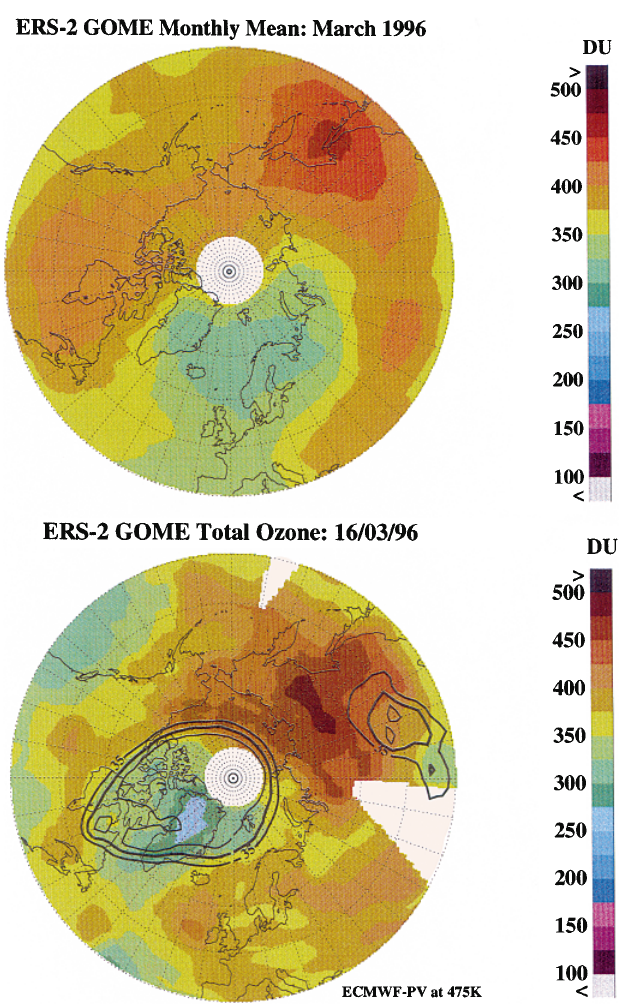
Fig. 7. GOME total ozone measurements in March 1996. Top panel : monthly mean total ozone in the Northern Hemisphere for March 1996. Bottom panel : total ozone on 16 March 1996. Black lines indicate the edge of the vortex; contour lines for 35 ( thick line with label ), 42 ( thick line ) and 48 ( thin line ) 10 (cid:255) 6 K m 2 (kg s) (cid:255) 1 are shown